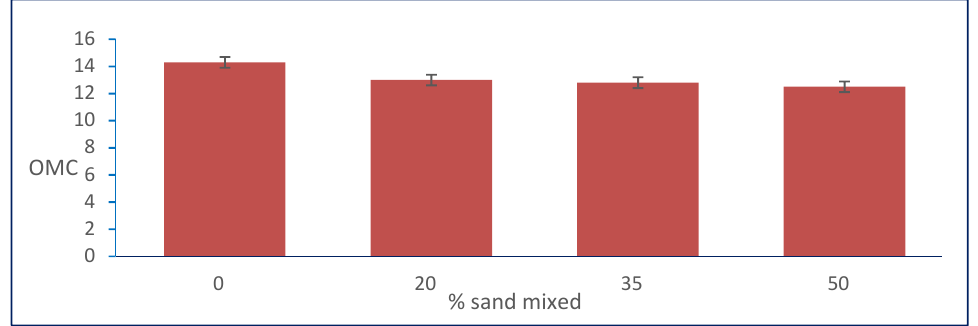
Figure 13. Effect of sand on optimum moisture content.